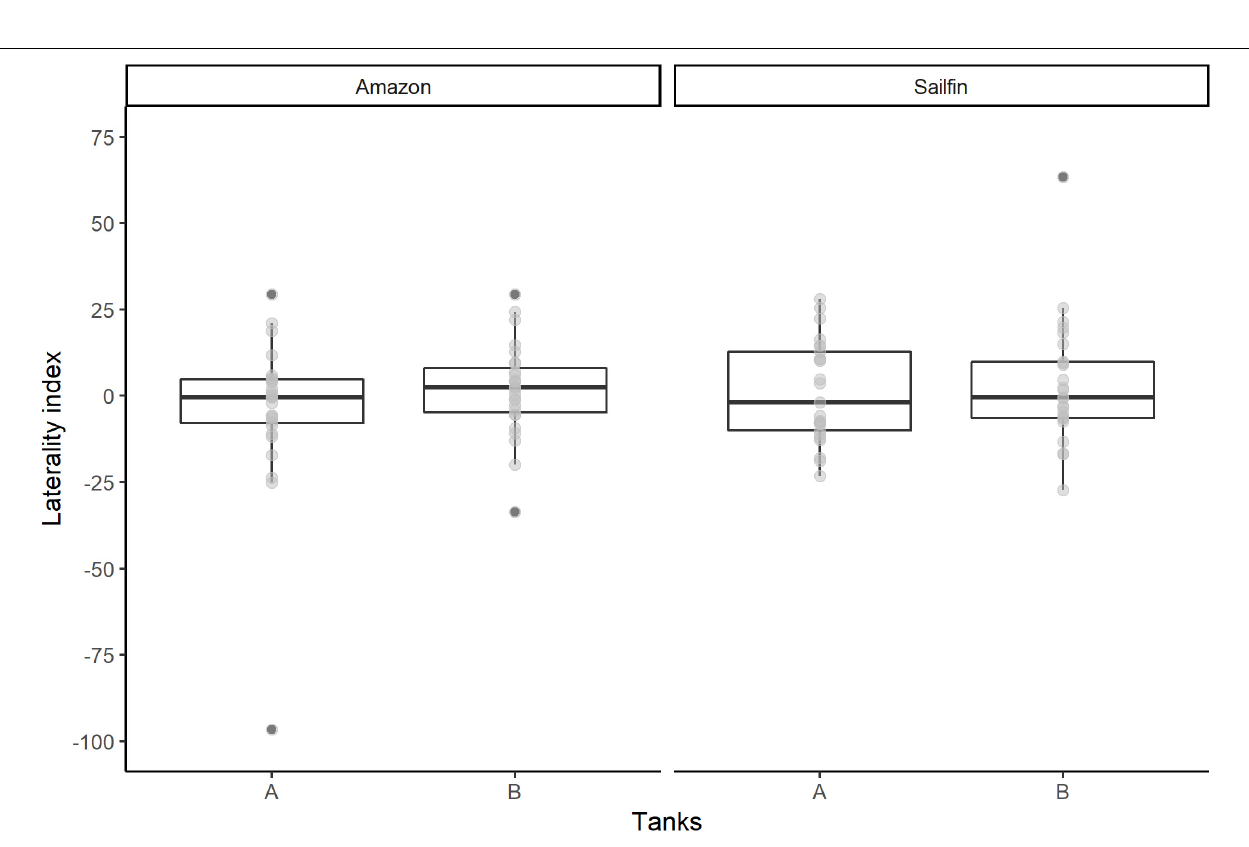
FIGURE 2 | Boxplots (— , median; (cid:3) , 25–75th percentile; outliers in dark gray; raw data in light gray) of laterality index scores across tanks for both species. Eye use did not significantly differ between tank A and B for either Amazon mollies or sailfin mollies (paired t -tests).